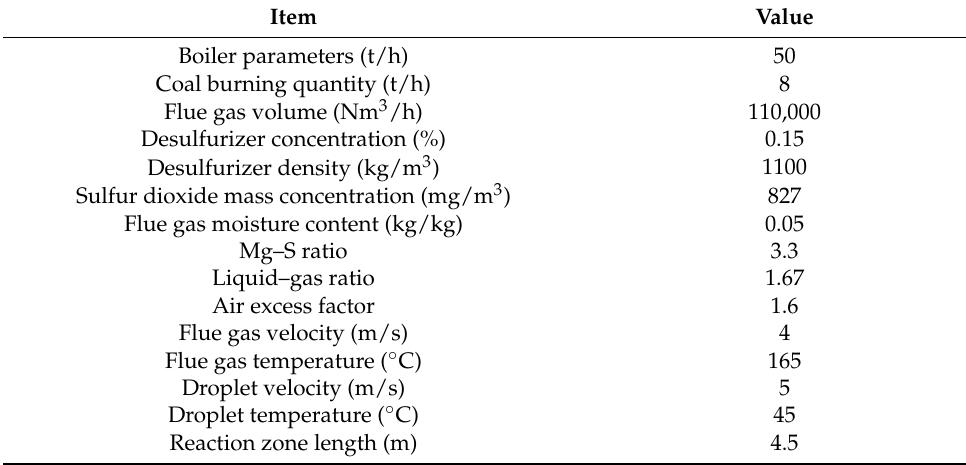
Table 1. The working media and structural parameters of the desulfurization tower.